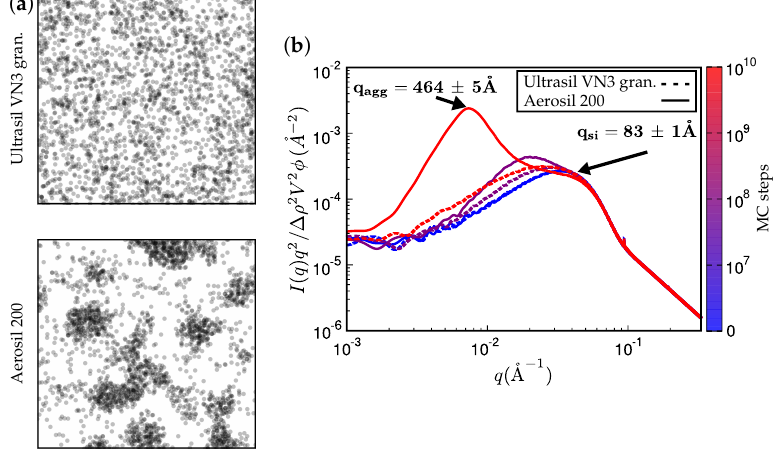
Figure 11. ( a ) simulated TEM images. ( b ) attendant simulated SAXS curves. The rubber is polychloroprene rubber (CR, Lanxess Baypren, γ d p = 19.3 mJ/m 2 and γ p p = 23.7 mJ/m 2 ) at 80% (by volume). Each system is either filled with 15% Ultrasil VN3 gran. at T = 160 ◦ C (top TEM and dashed SAXS curves) or, alternatively, with Aerosil 200, thus leading to a silane content of 5% (by